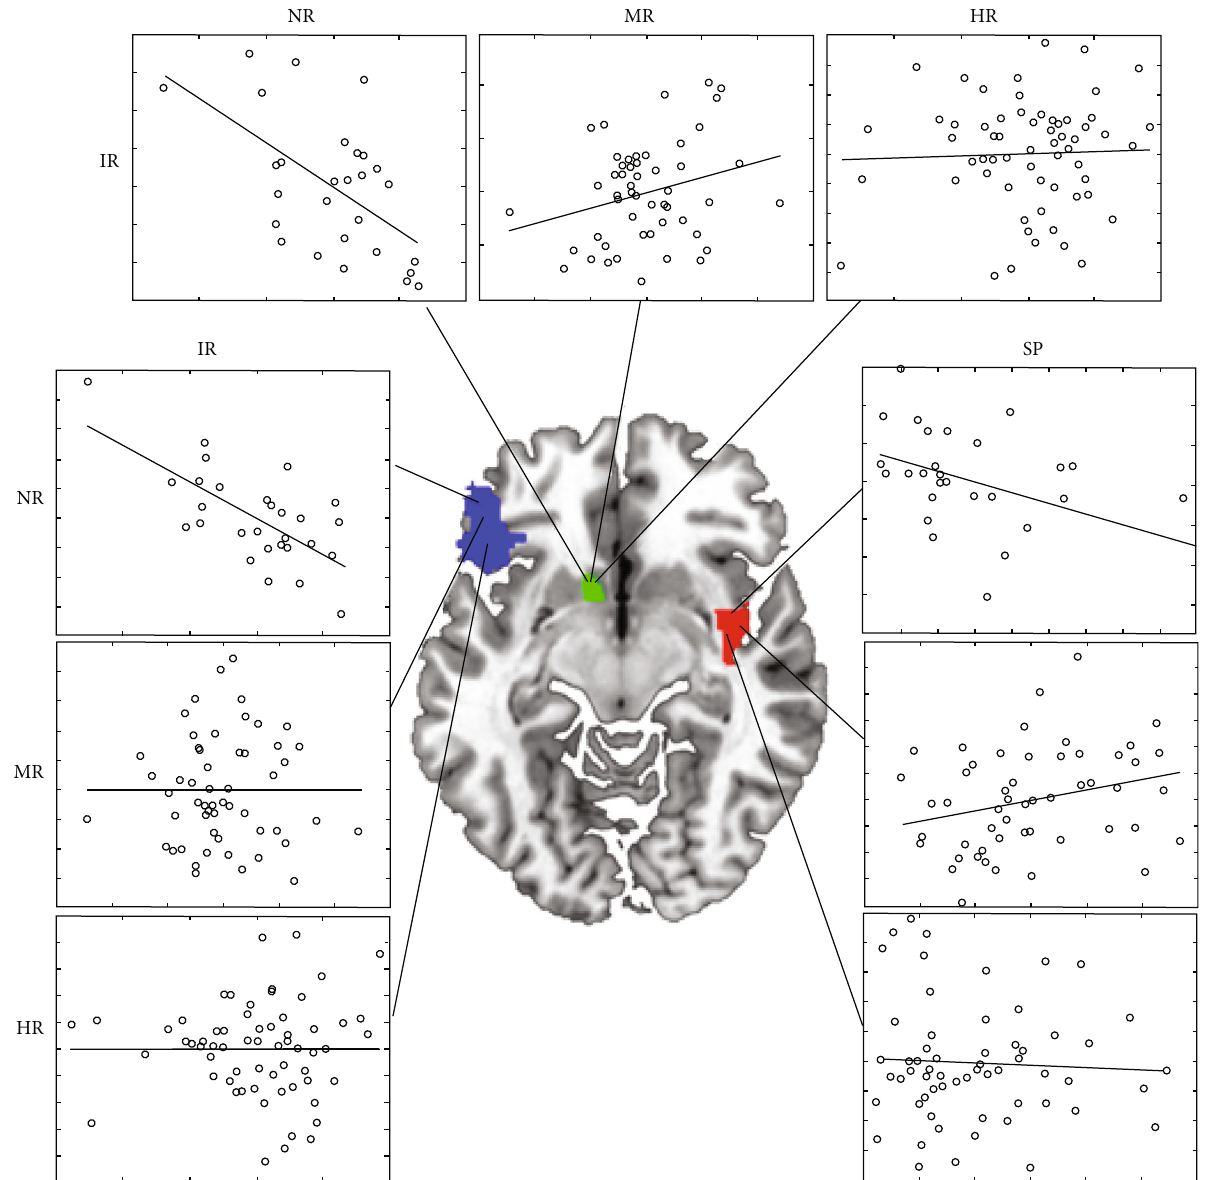
Figure 1: An illustration of the correlations between the brain parcels (left accumbens, left inferior frontal orbital gyrus, and right posterior insula) and preference for immediate rewards (IR) and sensitivity to punishment (SP) for each risk